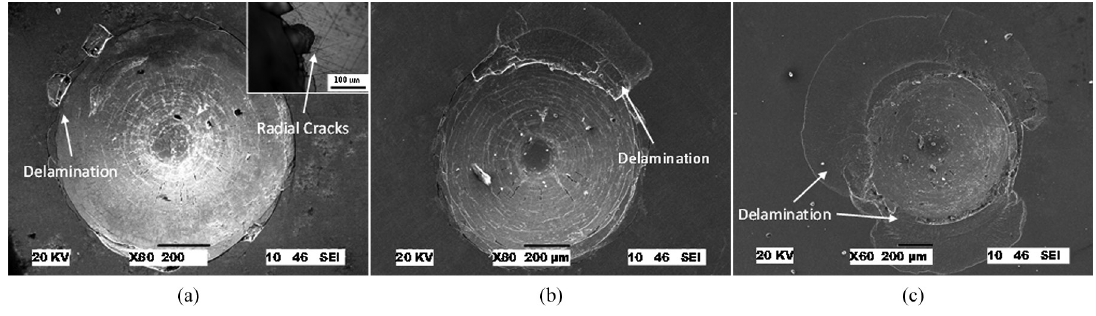
Figure 7. SEM micrographs of Daimler-Benz adhesion test on AISI 304 steel borided at 1223 K and different exposure times: (a) 2 h, (b) 6 h and (c) 10 h.